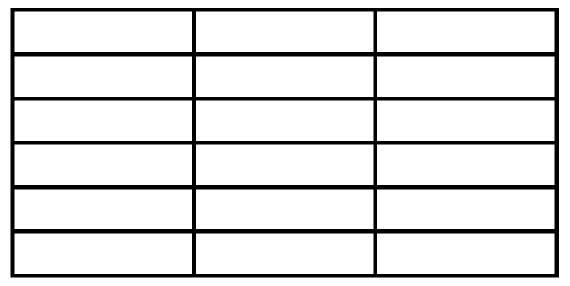
Figure 1. The first table mentioned in the text.